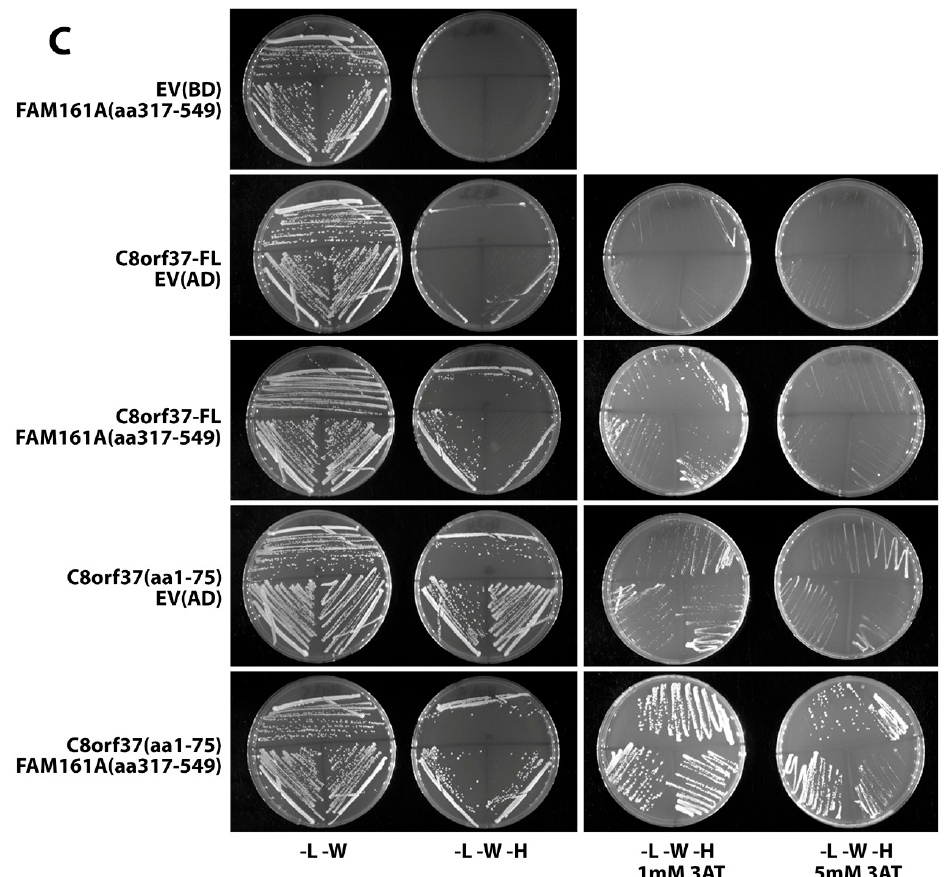
Figure 5. N-terminus of C8orf37 interacts with the UPF0564 domain of FAM161A. Y2H assays were performed to identify the region of interaction on C8orf37 and FAM161A. Transformants were plated at different dilutions on selective medium lacking leucine and tryptophan (-L -W); on medium lacking leucine, tryptophan, and histidine (-L -W -H); on stringent selective medium lacking leucine, tryptophan, and histidine treated with 1mM 3-amino-1,2,4-triazole (-L -W -H +1 mM 3AT); and on medium lacking leucine, tryptophan, and histidine treated with 5mM 3AT (-L -W -H +5 mM 3AT). Schematic ( A ) shows full-length C8orf37, mutant C8orf37, and C8orf37 fragments used in the Y2H experiments. Images in ( B ) show that positive interaction, indicated by colony growth, could be observed between full length C8orf37 (C8orf37–FL) and FAM161A (aa 317–549), C8orf37-R177W and FAM161A (aa 317–549), and C8orf37-Q182R and FAM161A (aa 317–549). No growth was observed between C8orf37 (aa 69–207) and FAM161A. Images in ( C ) show that positive interaction could be observed between the N-terminal fragment of C8orf37 (aa 1–75) and FAM161A (aa 317–549) on -L -W -H plates treated with 1 mM 3AT and 5 mM 3AT, respectively. Abbreviations: EV, empty vector; BD, binding domain; AD, activation